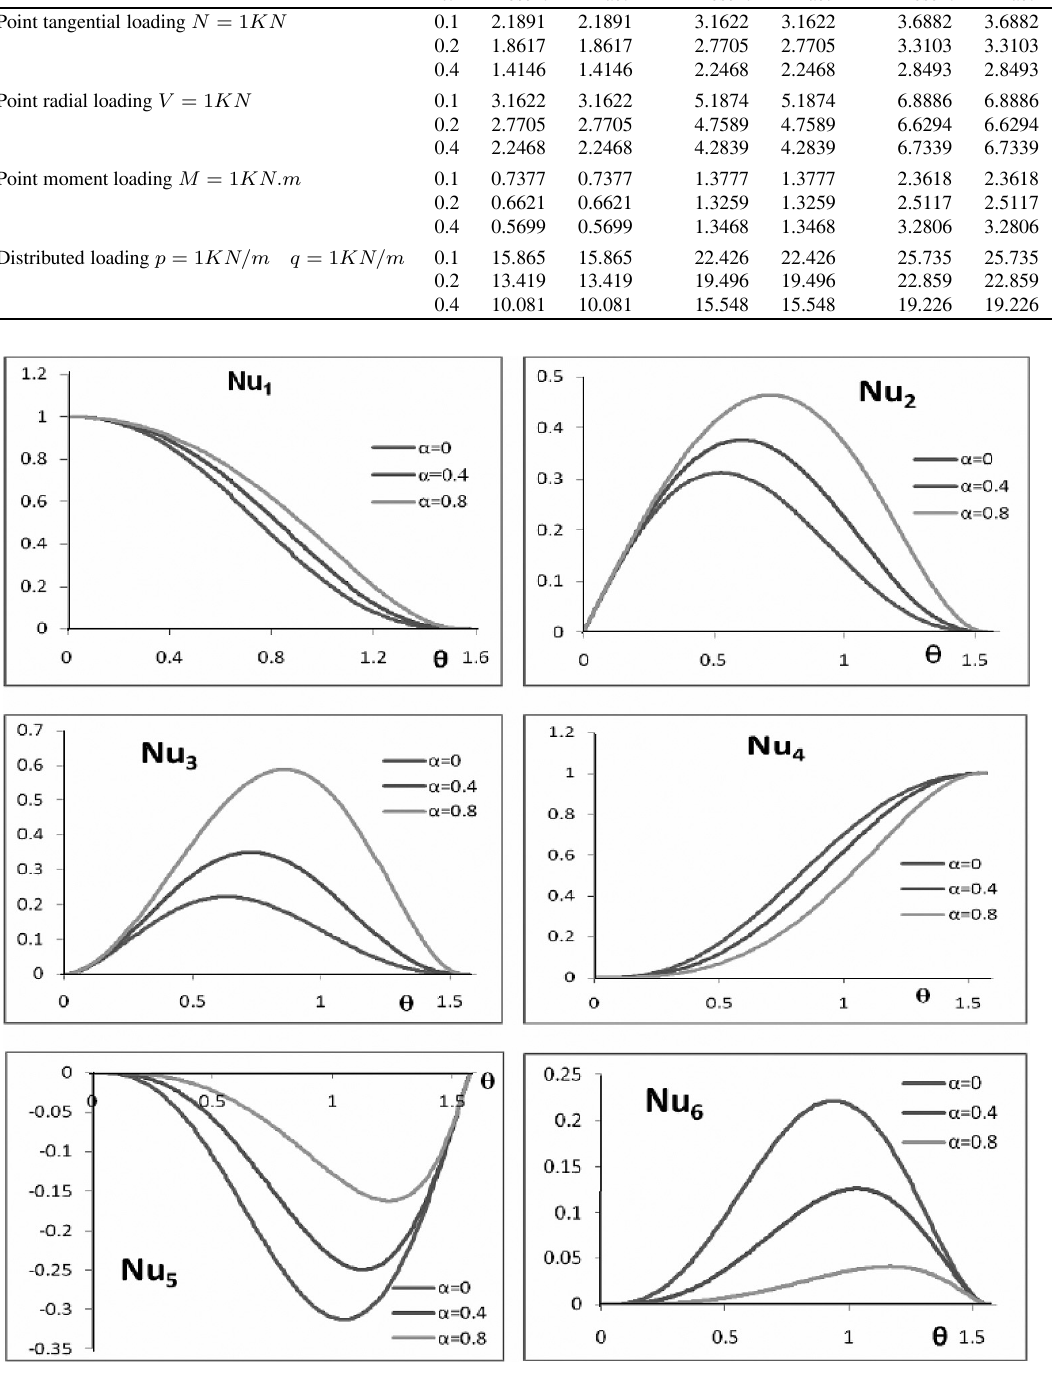
Fig. 7. Variation of tangential shape functions N u with taper